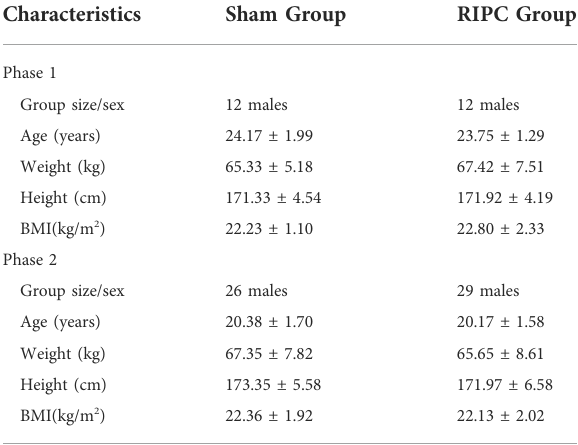
TABLE 1 Characteristics of participants in the sham and RIPC groups.